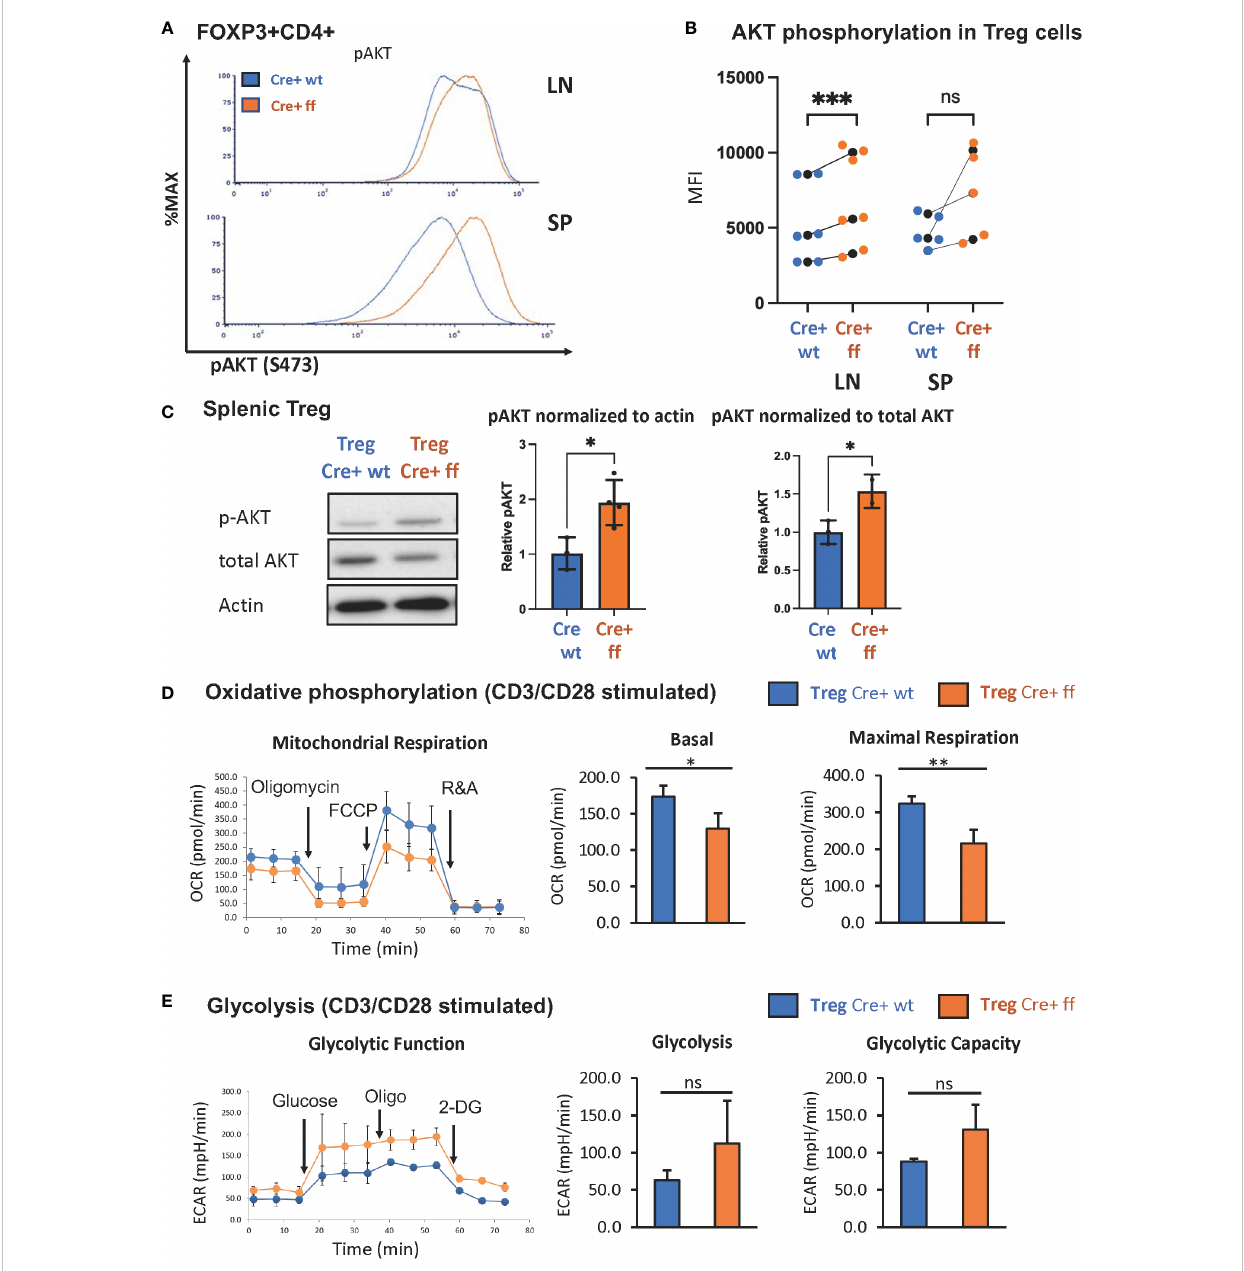
FIGURE 3 Treg speci fi c SHP-1 deletion increases phosphorylation of AKT and affects cellular metabolism . (A) AKT phosphorylation (Ser473) in freshly isolated Treg of 6-8 weeks old mice. Data are representative of 3 independent experiments. (B) MFIs of pAKT of Foxp3 Cre+ Shp-1 f/f Treg cells and Foxp3 Cre+ control Treg cells from lymph node or spleen were plotted. Each colored dot represents one data point. Average values for each genotype from the same experiment are shown as black dot and matched by lines for each experiment. Two-way ANOVA test was performed for statistics. LN p-value = 0.0005, SP p-value = 0.0521. Data are gated singlets → live cells → CD3 → CD4 → Foxp3 (C) Immunoblot analysis of p-AKT(S473), total AKT and b -actin from control Foxp3 Cre+ ( “ cre wt ” ) and Foxp3 Cre+ Shp-1 f/f ( “ cre ff ” ) mutant Treg cells stimulated with anti-CD3/CD28 beads + IL-2 (200U/ml) for 5 min. Relative pAKT quantity were normalized to actin and total AKT. Unpaired t test was used for statistics. pAKT/actin p-value = 0.0220, pAKT/ total AKT p-value =0.0464. (D, E) CD4+CD25+ Treg cells of Foxp3 Cre+ Shp-1 f/f or Foxp3 Cre+ control mice were stimulated with CD3/CD28 Dyna beads according to the manufacture ’ s protocol overnight and using a Seahorse bioanalyzer. (D) Basal and maximal mitochondrial respiration and (E) glycolysis and glycolysis capacity were measured to assess (D) OCR and (E) ECAR respectively, n=3 for each genotype. Error bar represents (B) SD and ( D , E ) s.e.m., two-sided t test, *p<0.05, **p<0.01, ***p<0.001, ns, not signi fi